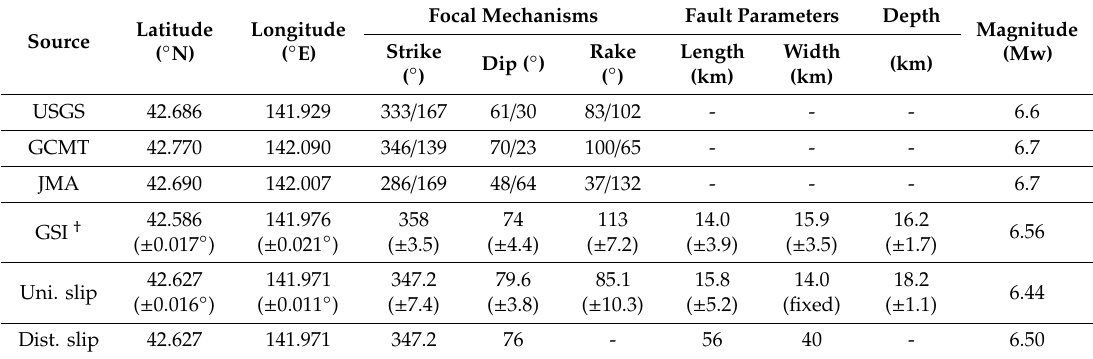
Table 1. Focal mechanisms and fault parameters from di ff erent